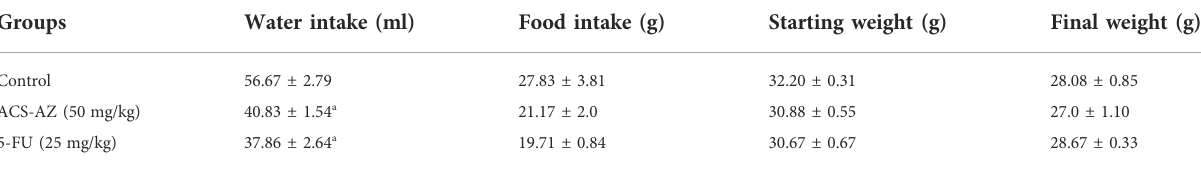
TABLE 2 Effects of a 7-day treatment with ACS-AZ or 5-FU on body weight and feed and water consumption of Ehrlich ascites carcinoma-bearing mice.